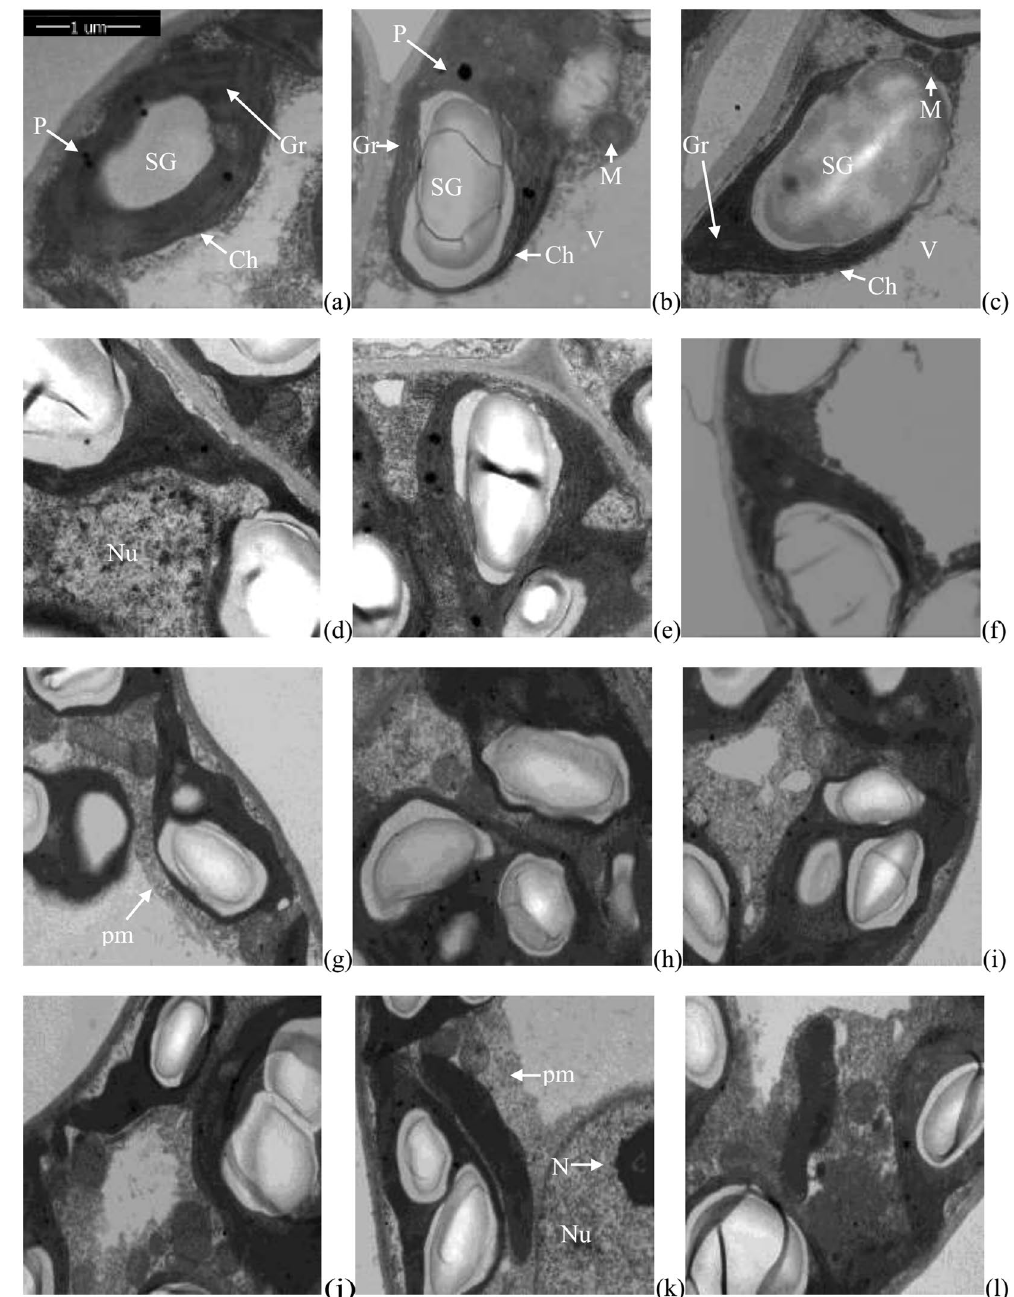
Figure 7. Ultrastructural variations in male and female P. deltoides under winter flooding stress and post- flooding recovery. CK, control treatment; W, flooding and waterlogging stress treatment; R, recovery after waterlogging stress. ( a ) CK females; ( b ) W-90d females; ( c ) W-140d females; ( d ) CK males; ( e ) W-90d males; ( f ) W-140d males; ( g ) CK-R females; ( h ) W-90d-R females; ( i ) W-140d-R females; ( j ) CK-R males; ( k ) W-90d-R males; ( l ) W-140d-R males. Ch, chloroplast; Gr, granum; M, mitochondrion; N, nucleolus; Nu, nucleus; P, plastoglobule; SG, starch grain; V,